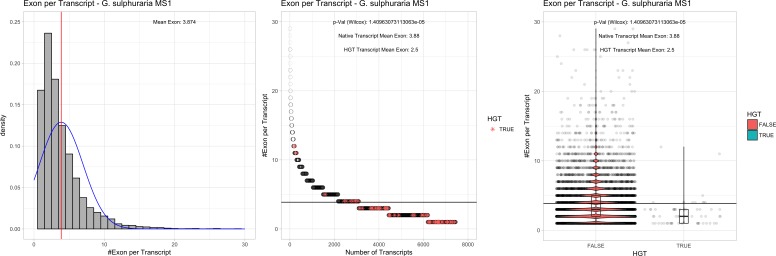
Exon/Intron – Galdieria sulphuraria MS1: (Left) Mid) Cumulative %GC distribution of transcripts.Red line shows the average, blue line a normal distribution based on the average value. The data is categorical (genes have either one, two, three etc. exons) and does not follow a normal distribution. (Mid) Ranking all transcripts based upon their number of exons. Red ‘*' demarks HGT candidates. As the number of exons was not normally distributed, transcripts were ranked by number of exons. In order to resolve the high number of tied ranks (e.g. many transcripts have two exons) a bootstrap was implied by which the rank of transcripts sharing the same number of exons was randomly assigned 1000 times. Wilcoxon-Mann-Whitney-Test applied for the determination of significant rank differences between the native gene and the HGT candidate subset. (Right) Violin plot showing the number of exons per transcript distribution across native transcripts and HGT candidates.